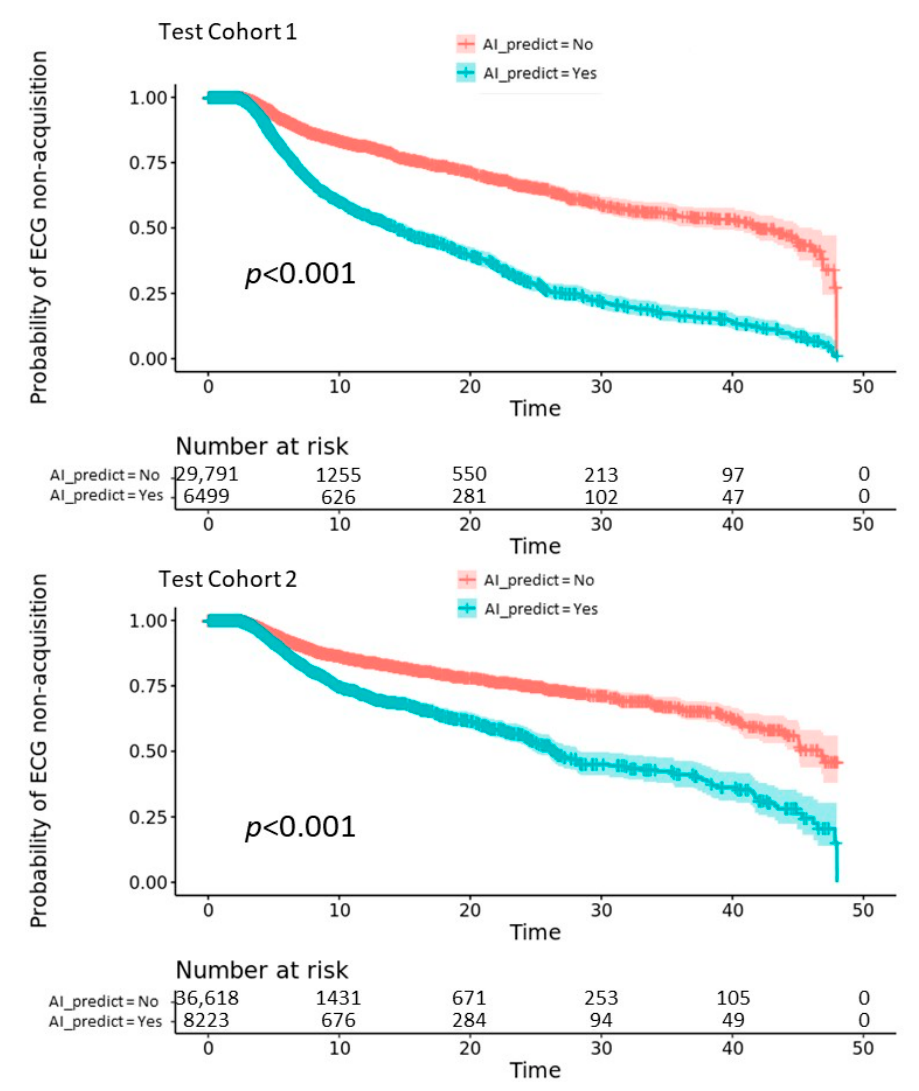
Figure 5. ECG acquisition in initially ECG non-acquisition patients stratified by AI model. The red line demonstrates patients correctly stratified by AI model (true negative), and the blue line demonstrates patients incorrectly stratified by AI model (false positive). The ordinate shows the cumulative probability of non-acquisition of an ECG and the abscissa indicates hours from time of the ED admission.